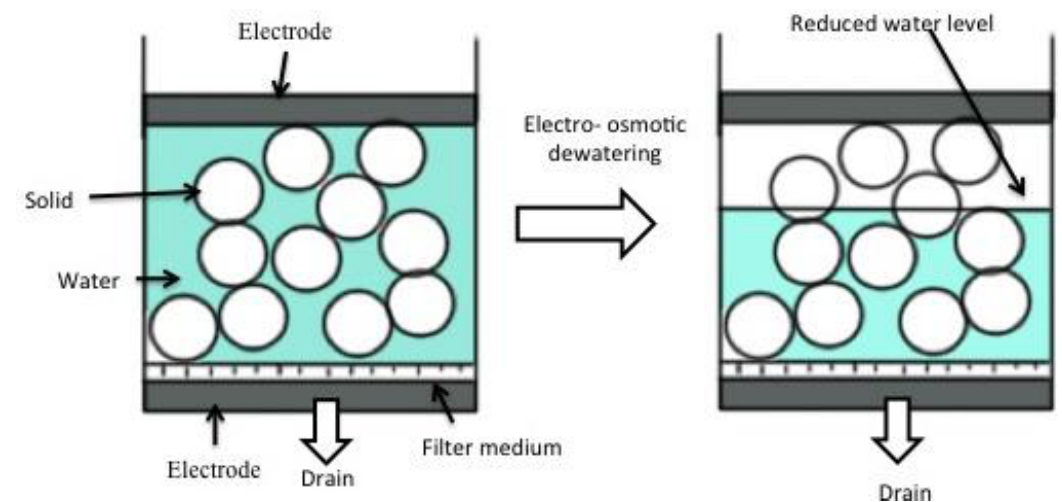
Figure 2. Process of dewatering by electro osmosis dehydration